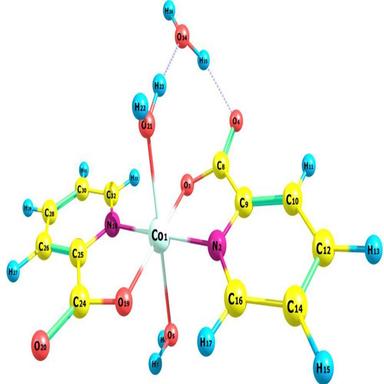
Optimized molecular structure of PCOH.